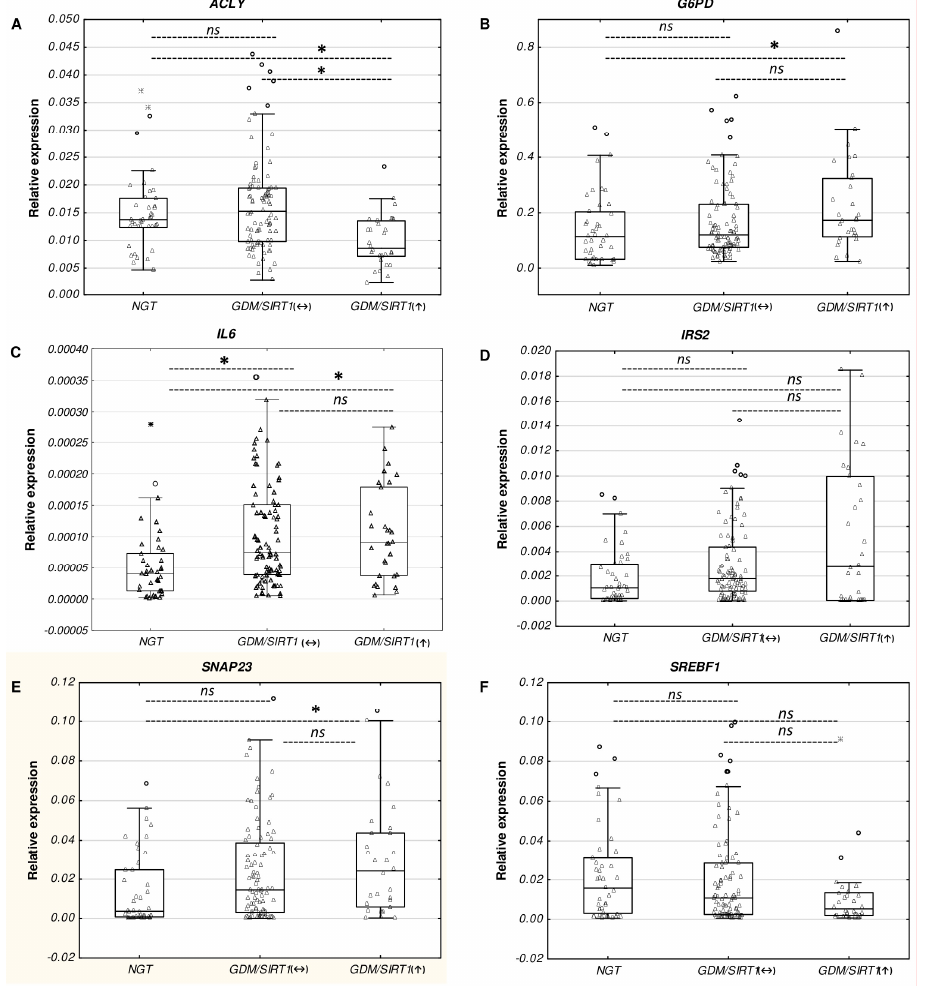
Figure 2. Verification results of the genes ACLY ( A ), G6PD ( B ), IL6 ( C ), IRS2 ( D ), SNAP23 ( E ), and SREBF1 ( F ) in NGT ( n = 41), GDM/ SIRT1 ( ↔ ) ( n = 92), and GDM/ SIRT1 ( ↑ ) ( n = 30) groups by RT-qPCR. All mRNA levels of the investigated genes were normalized to a mean of the endogenous control GAPDH . Data are expressed as median ± interquartile range (25–75%); * p < 0.05, as assessed by post hoc test for pairwise multiple comparisons of mean rank sums; n.s.: